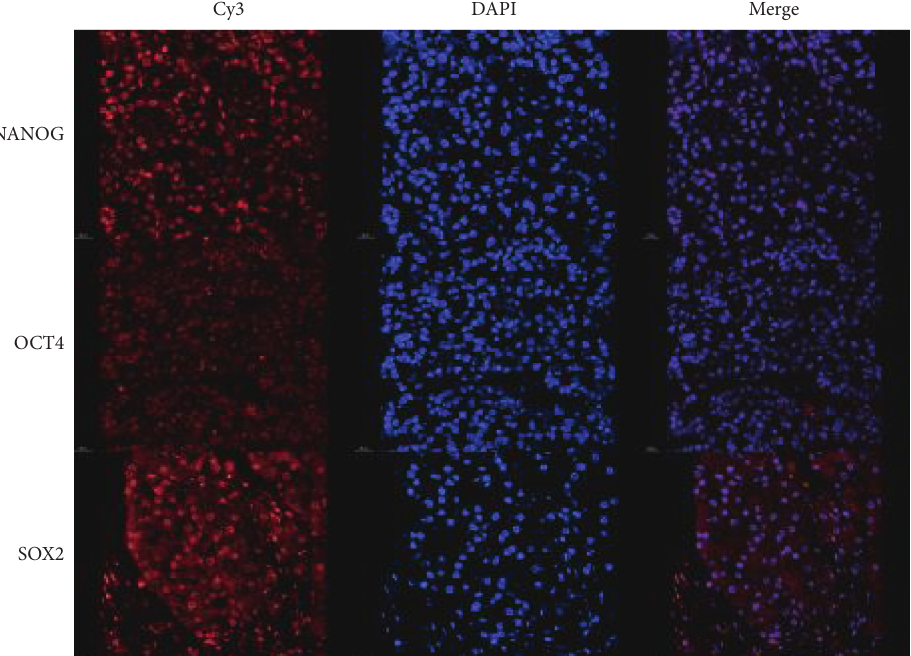
Figure 4: Immunofluorescence staining showing NANOG nuclear reactivity; OCT4 reactivity is predominantly nuclear and scant in the cytoplasm; SOX 2 immunoreactivity is localized to both nucleus and cytoplasm (Cy3: cyanine dye; DAPI: